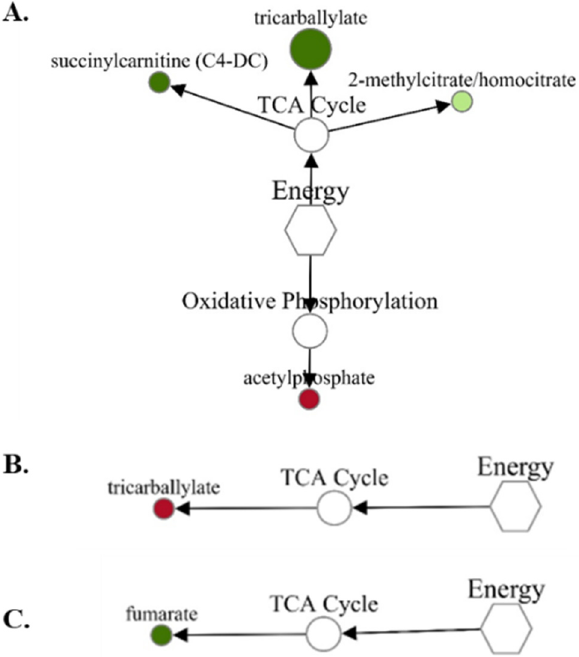
Figure 3. Network comparison of energy metabolites relative flux in fetal liver of VTM-LG vs. NOVTM-LG ( A ), NOVTM-MG vs. NOVTM-LG ( B ), and VTM-MG vs. NOVTM-LG ( C ). VTM = supplemented with vitamin/mineral. NOVTM = not supplemented with vitamin/mineral. LG = fed to gain 0.28 kg/day. MG = fed to gain 0.79 kg/day. Node diameter is proportional to the fold-change observed. Node color represented the significance of the change: dark red is an increase ( p ≤ 0.05), light red is a tendency to increase 0.05 < p ≤ 0.10), dark green is a decrease ( p ≤ 0.05), and light green